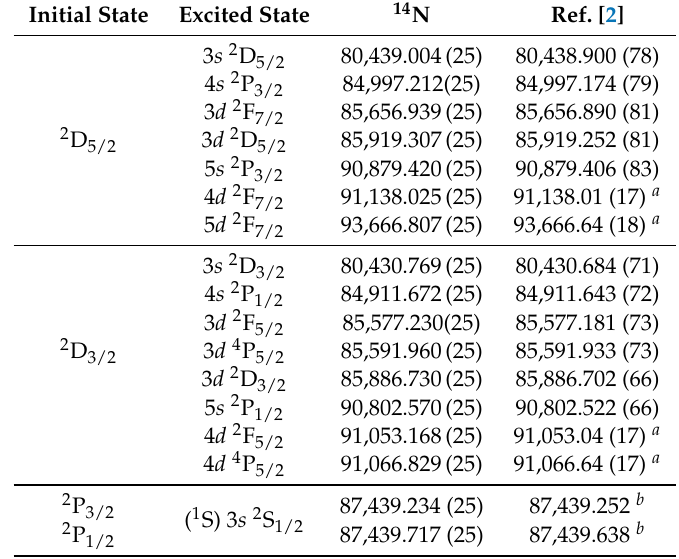
Figure 3. Spectra of 14 N I transitions excited from the metastable 2 D J states in the range 85,500–86,000 cm − 1 . Shown as well is the reference Kr I line used for calibration. Table 2. Measured transition frequencies for lines excited from 2 D J and 2 P J metastable states in N I, with uncertainties indicated in parentheses. Again, a comparison is made with results from [2]. All values in cm − 1